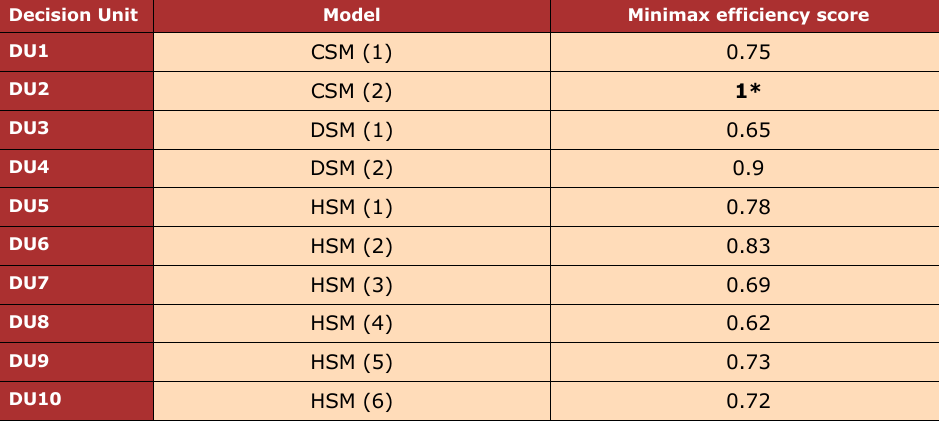
Table 16. Selecting the most efficient configuration for the high interaction